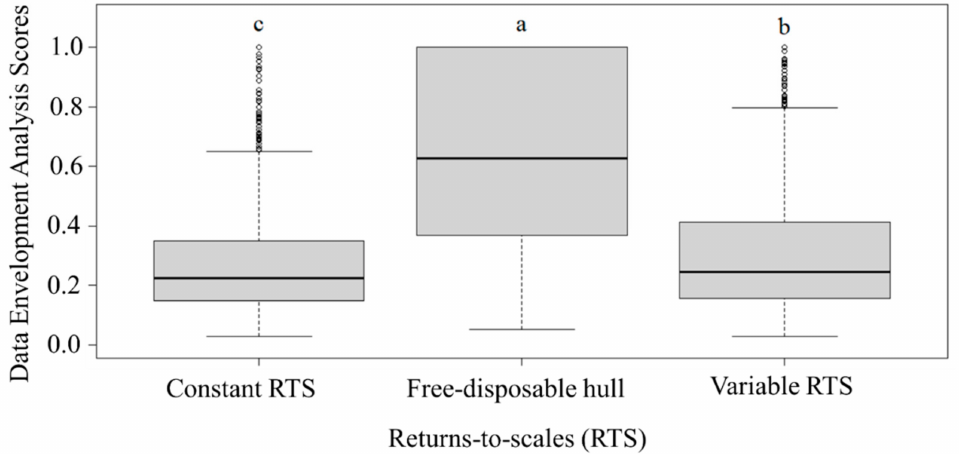
Figure 1. Data Envelopment Analysis scores by different types of returns-to-scale (RTS). Note that letters denote significant differences in means between the variables based on the analysis of variance test with Tukey’s distance approximation ( p <